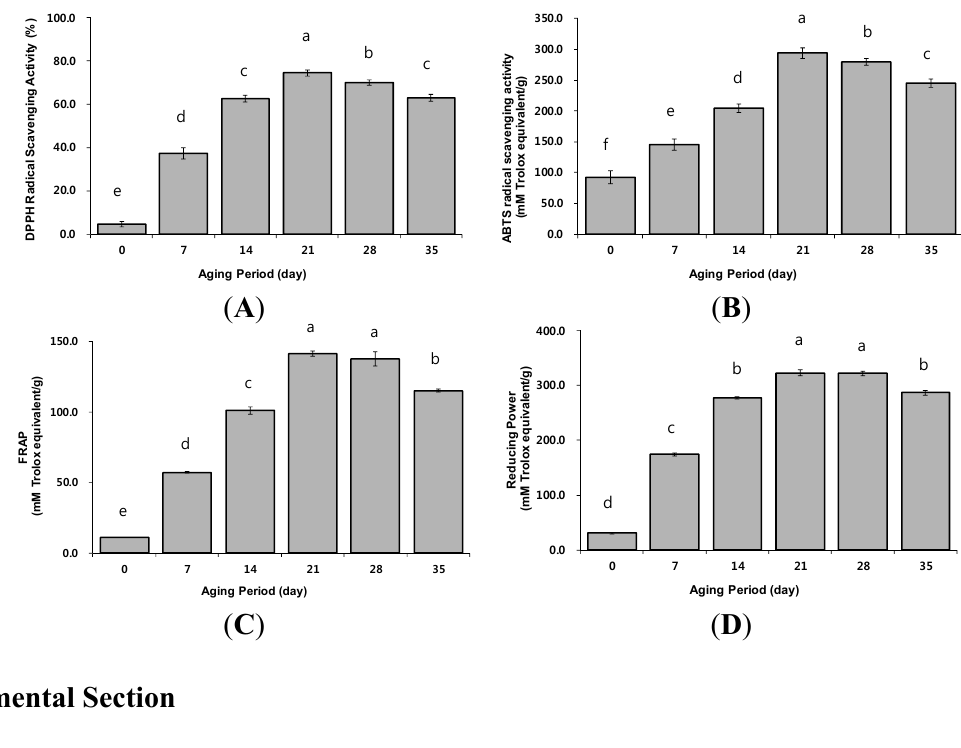
Figure 3. Antioxidant activities of black garlic during the aging period. ( A ) DPPH radical scavenging; ( B ) ABTS radical scavenging; ( C ) Fe(III) reducing (pH 3.6); ( D ) Fe(III) reducing (pH 6.6). Different letters above the bars for the same aging periods indicate significant difference at p < 0.05 (Duncan’s